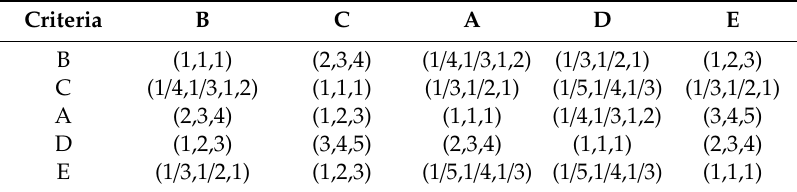
Table 8. Matrix of comparing pairs between main criteria by fuzzy numbers.